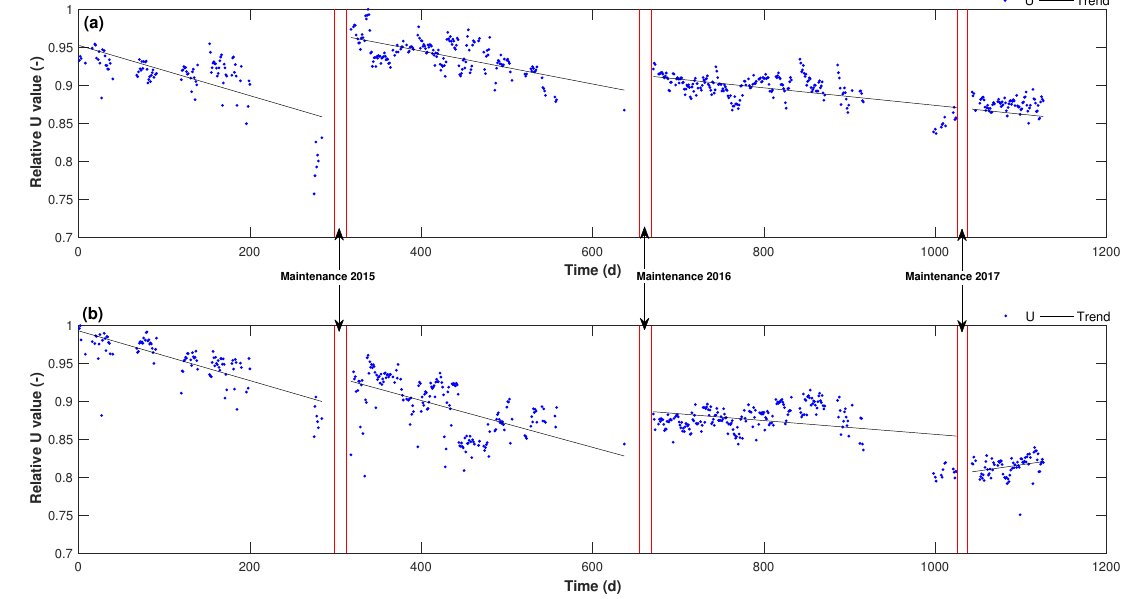
Figure 4. Normalized overall heat transfer coefficient for the evaporator ( a ) and SH3 ( b ) at full load. The red lines indicate the duration of